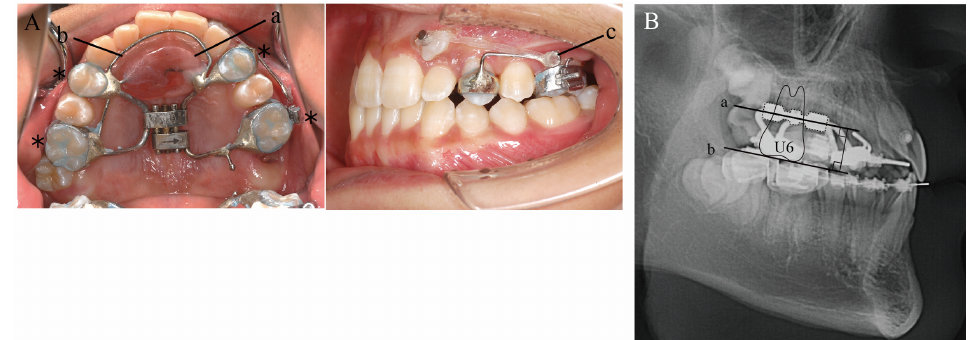
Figure 5. Orthodontic occlusal guidance appliance. ( A ) Intraoral photographs. Abutment bands (*); resin button (a); lingual arch (b); canine traction hook (c). ( B ) Lateral cephalogram. Expansion screw (dotted line); expansion screw placement plane (a); maxillary first molar (U6) occlusal surface